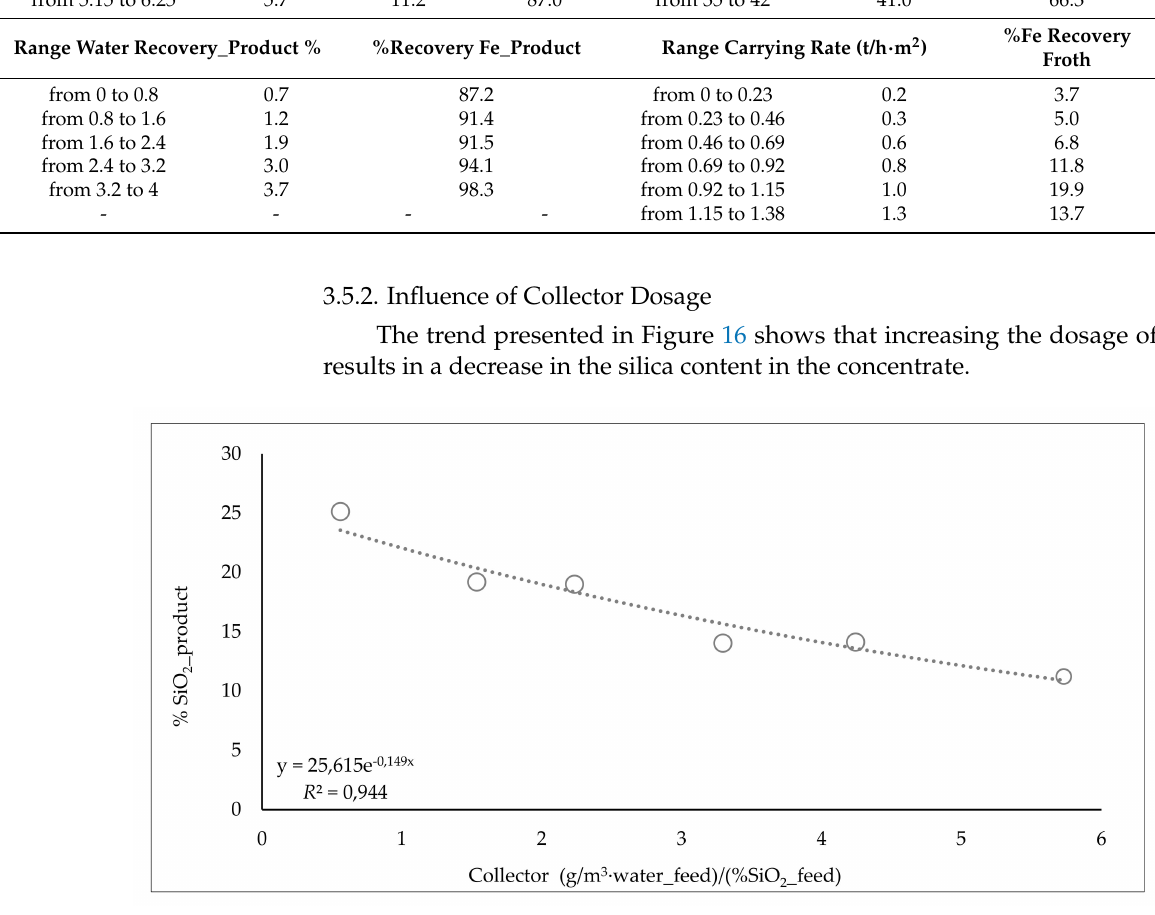
Figure 16. Trend between the amidoamine specific dosage and the SiO 2 content in the product